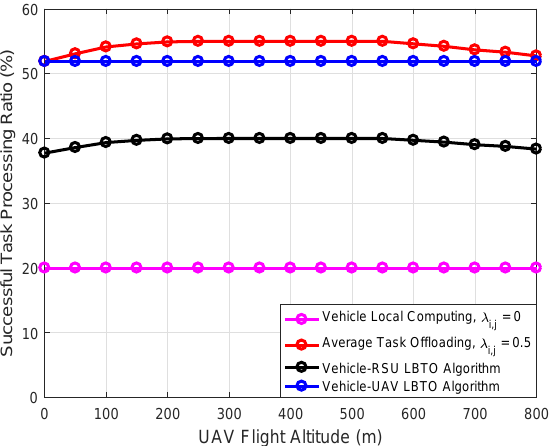
Figure 9. Comparison of the successful task processing ratio with respect to the UAV flight altitude under different algorithms.